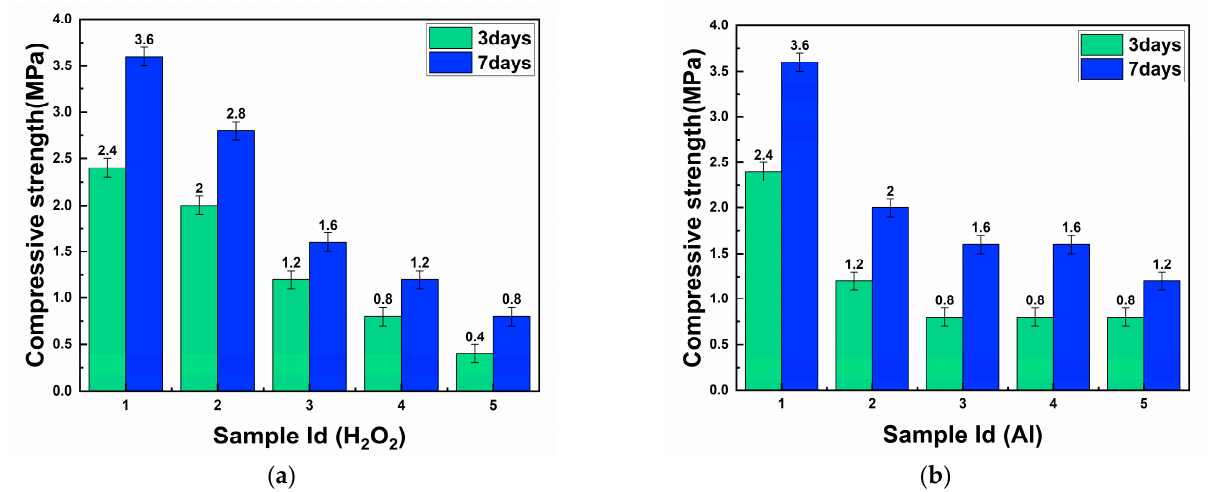
Figure 7. Effect of curing time on the compressive strength of porous geopolymers. ( a ) H 2 O 2 foaming and ( b ) Al foaming.